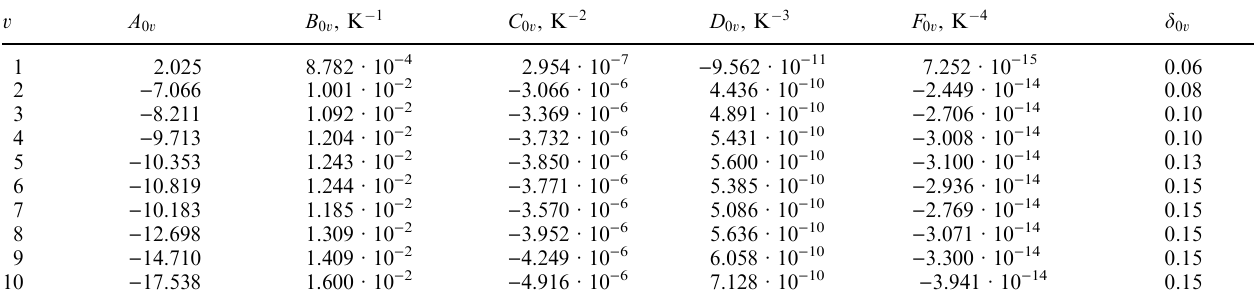
Table 1. Coe(cid:129)cients for calculations of Q 0 v for 1500 (cid:20) T e (cid:20) 6000 K